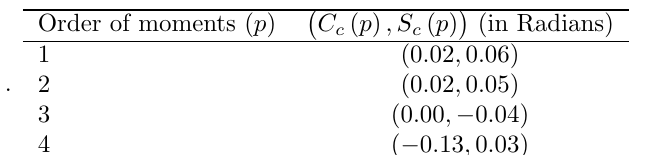
Censored Sample Trigonometric Moments about the Zero Direction for data shown in